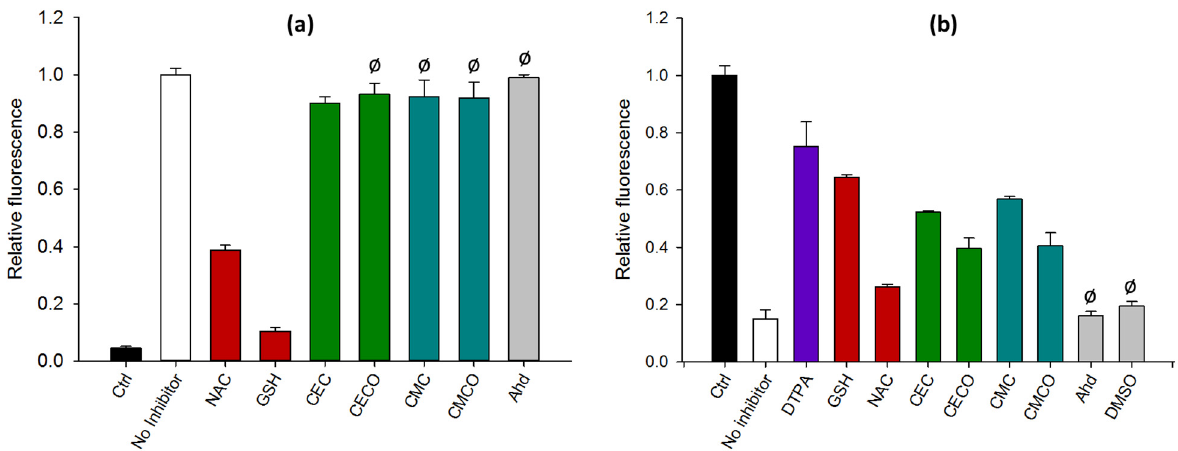
Figure 4. Testing antioxidant activities of β -CEC and β -CECO (1:1 diastereomeric mixture). ( a ) Scav- enging 40 µ M hydrogen peroxide in the Amplex Red assay. ( b ) Protection of dsDNA degradation in presence of 50 µ M copper/2 mM ascorbate/2 mM H 2 O 2 . Abbreviations: Ctrl, no H 2 O 2 ; DTPA, diethylenetriaminepentaacetic acid; NAC, N -acetyl-L-cysteine; GSH, reduced glutathione; Ahd, L -2- aminohexanedioic acid. Concentrations of inhibitors—1 mM; DMSO—0.5% v / v . For each treatment, n = 3. The differences in means were probed by the one-way ANOVA; ø indicates no statistically significant difference between a treatment and “no inhibitor” control; otherwise, p < 0.05.